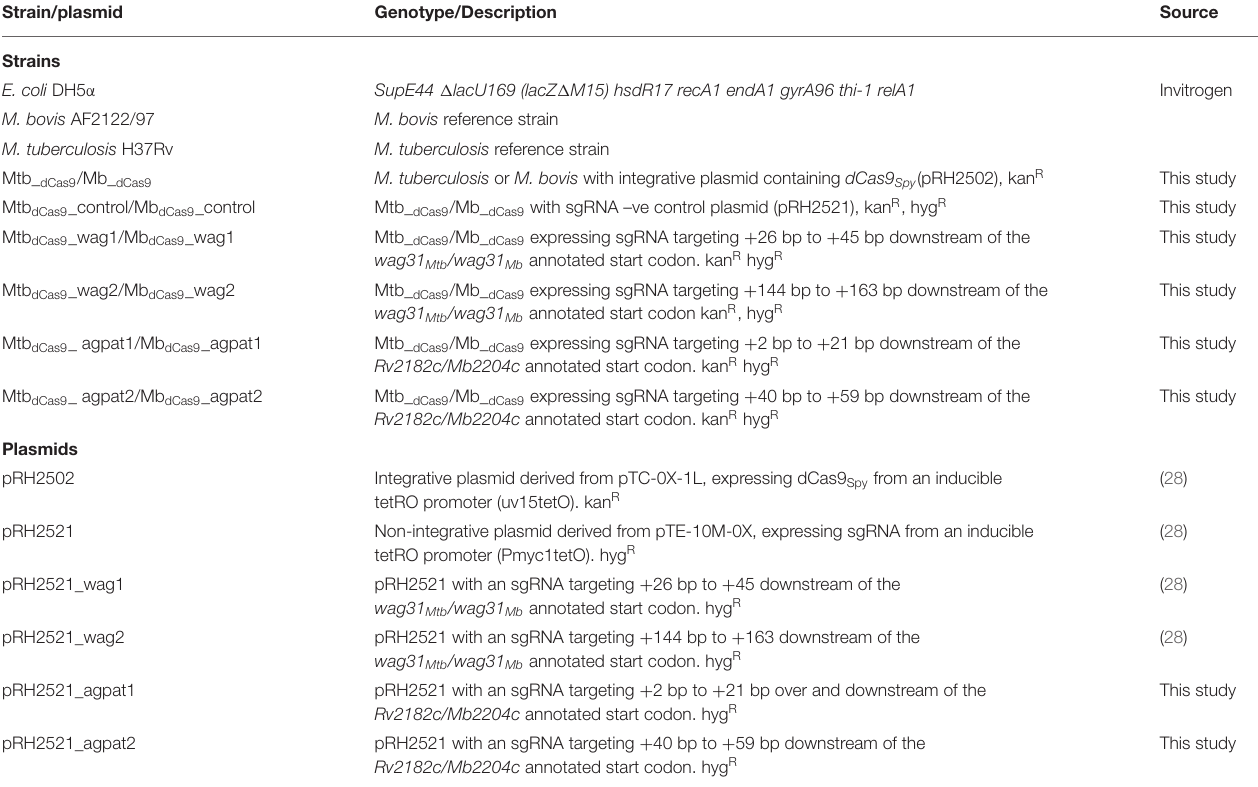
TABLE 1 | Strains and plasmids used in this